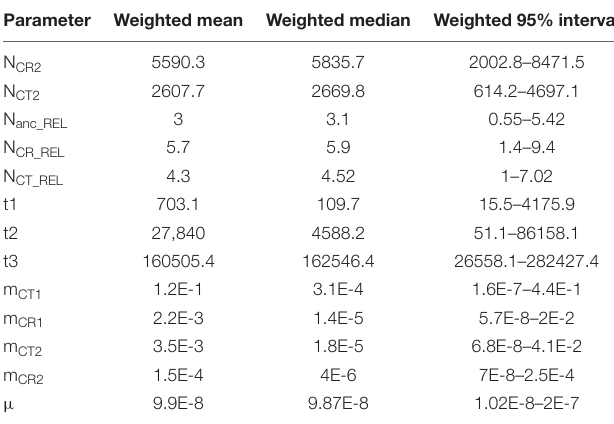
TABLE 4 | Parameter estimation of the approximate Bayesian computation continuous gene flow model. Parameter Weighted mean Weighted median Weighted 95%